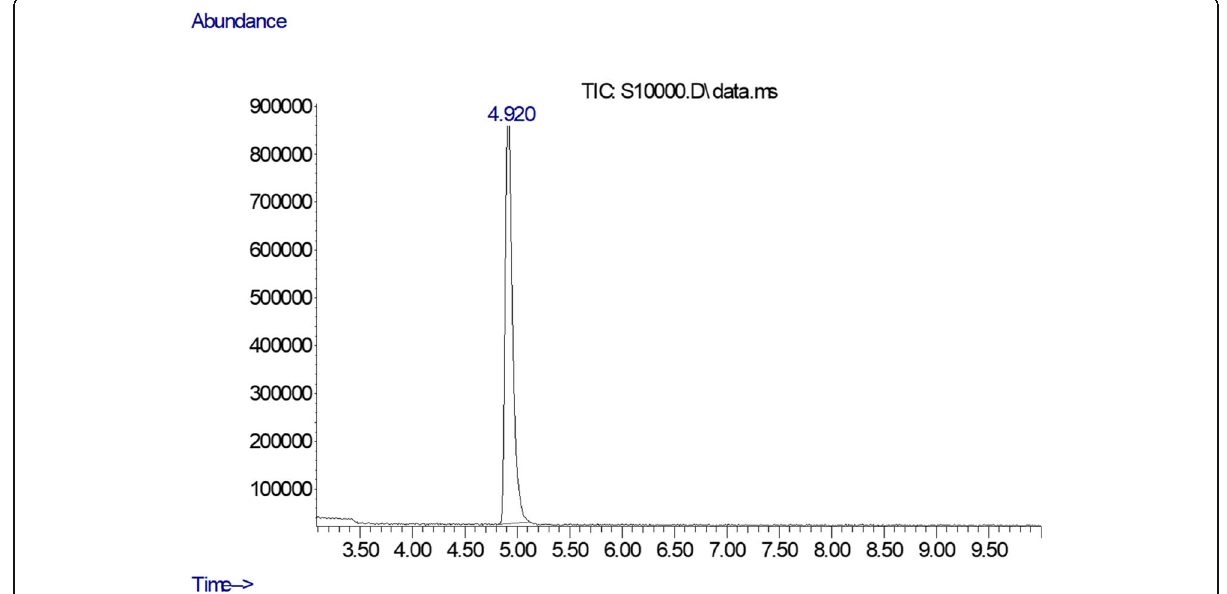
Fig. 2 Total ion chromatogram of Morphine (4.94 m/z) in the third instar larvae of L. cuprina after